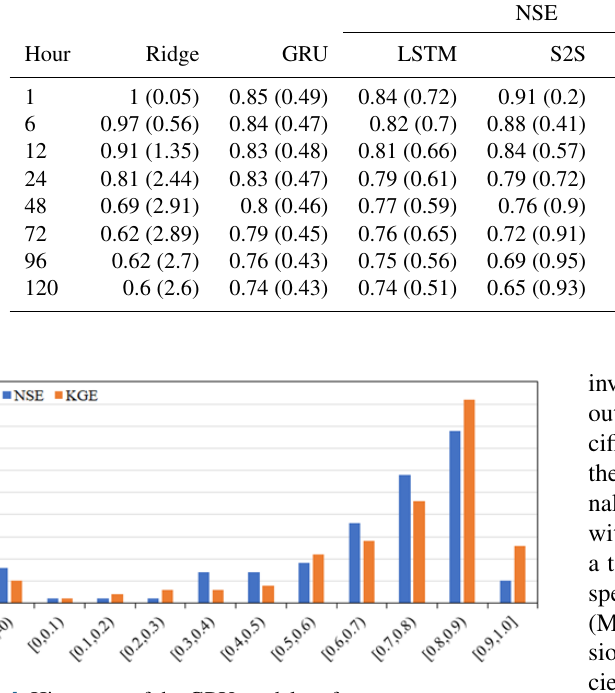
Figure 4. Histogram of the GRU model